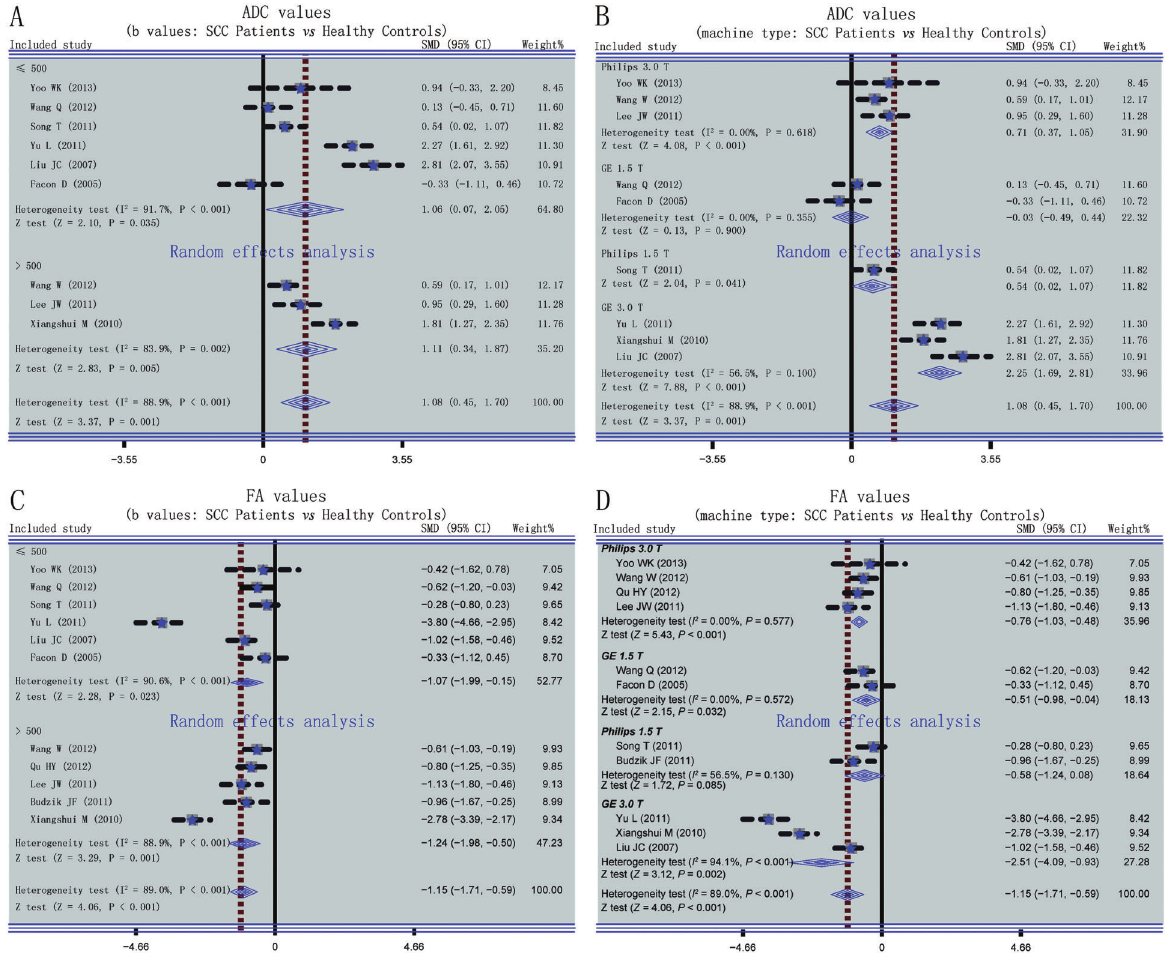
Figure 3. Subgroup analyses of the difference in the apparent diffusion coef fi cient (ADC) and fractional anisotropy (FA) values between patients with spinal cord compression (SCC) and healthy subjects ( A , ADC b value; B , ADC machine type; C , FA b value; D , FA machine type). See Figure 1 for reference details. SMD: standard mean